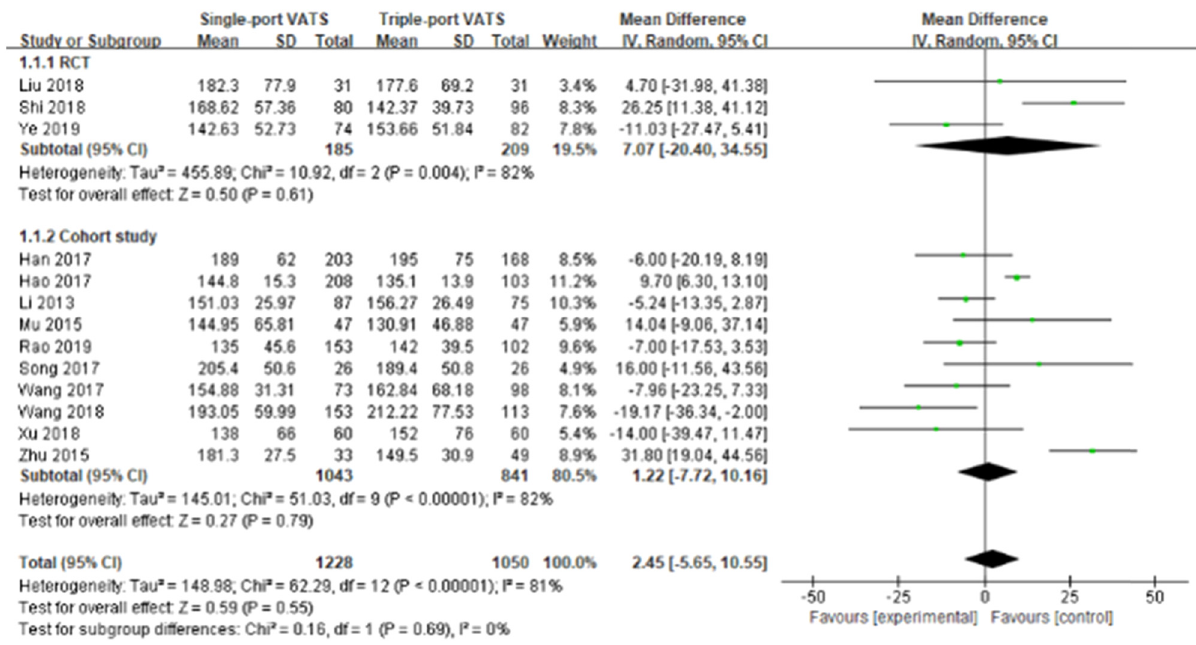
Figure 2: Forest plots of operation time for single - and triple - VATS lobectomy based on di ff erent research designs. For each study, the estimated OR ( shown as square ) and its 95% CI ( shown as horizontal line ) were plotted. The pooled OR and 95% CI were plotted as black diamond.